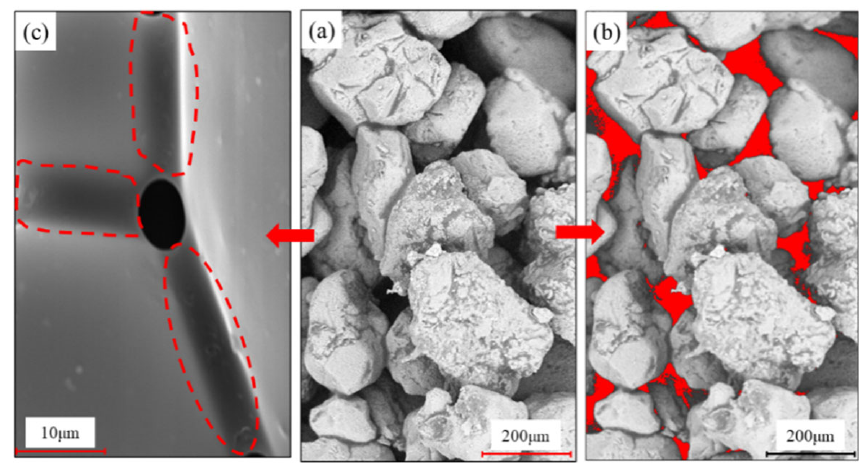
Figure 14. Binder bonding form between sand grains ( a ) (“binder neck” is highlighted by red dashed lines ( c )) and ( b ) pore space extraction of the 3DP rocks (highlighted in red) (Type I sand mixture is used as an example).